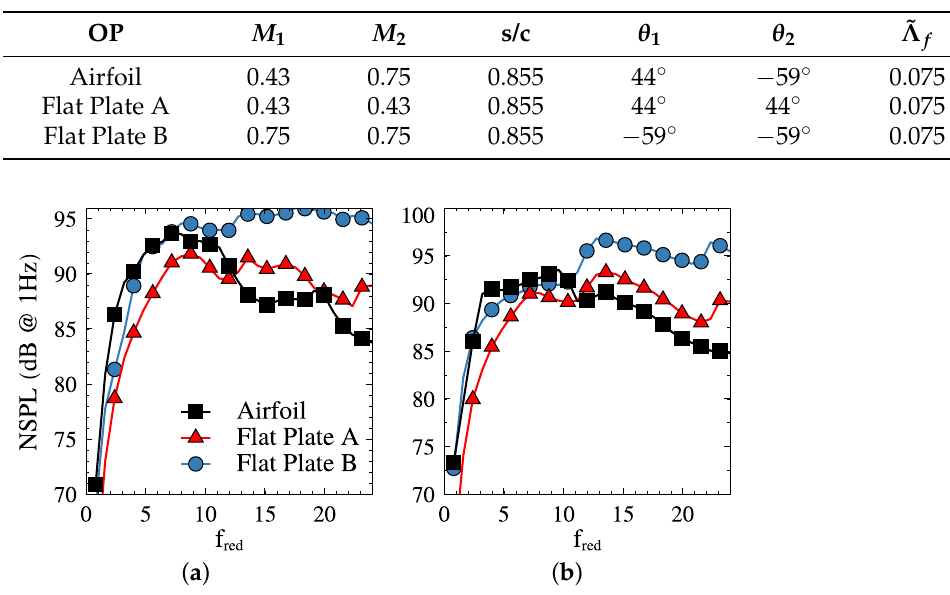
Table 2. Geometrical and flow parameter definitions of the airfoil and its equivalent flat plates.